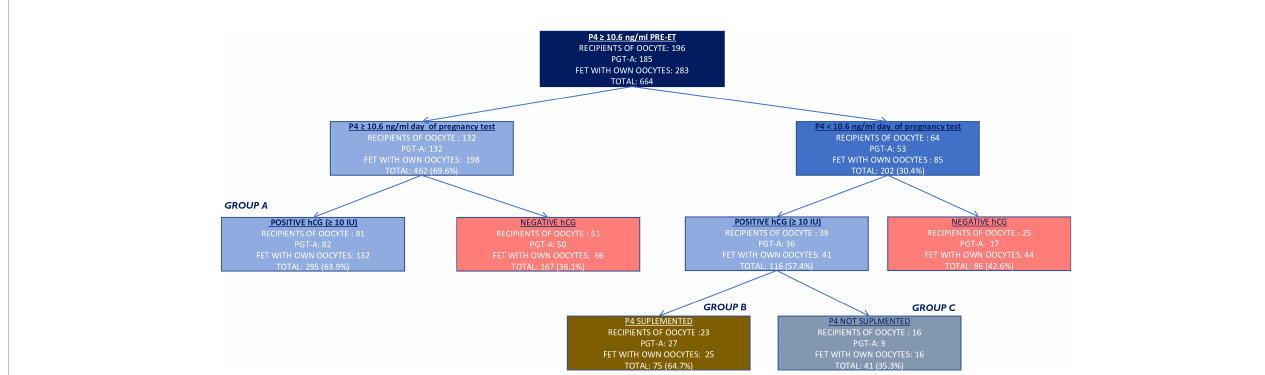
FIGURE 1 Flow chart of the study population and results. In red are the cycles excluded from the primary outcome. In gold is the supplementation on the day of hCG assessment. Positive hCG was considered when ≥ 10 IU. hCG, human chorionic